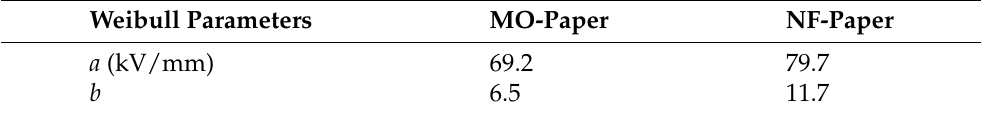
Table 2. Weibull parameters for the AC dielectric strength